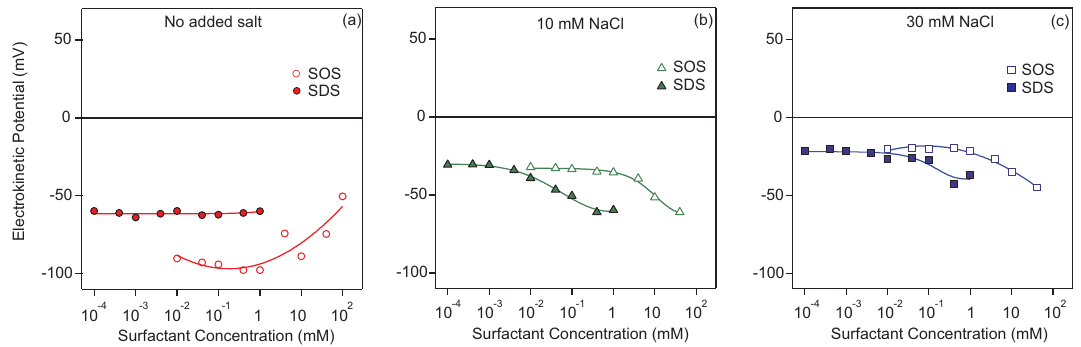
Figure 4. Electrokinetic potential of sulfate latex particles as a function of surfactant concentration with ( a ) no added salt, ( b ) 10 mM NaCl, and ( c ) 30 mM NaCl. Empty symbols represent SOS and full symbols SDS surfactants. The lines are empirical interpolation